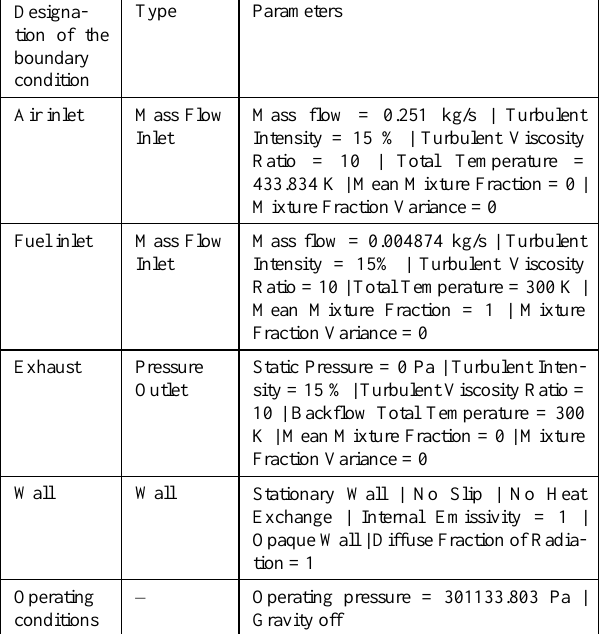
Table 3. Implemented boundary conditions Designa- tion of